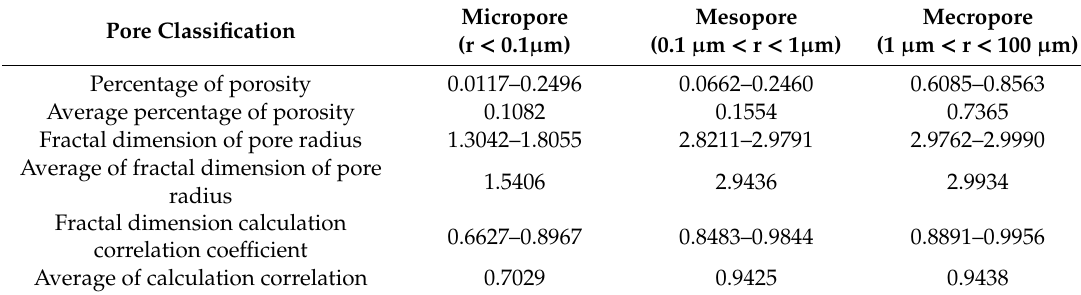
Table 6. Statistics of di ff erent pore fractal dimension